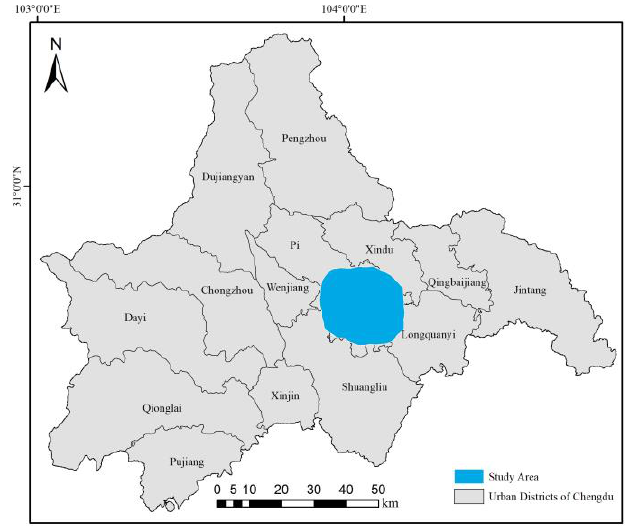
Figure 1. Study Area. The administrative division data are from the National Geomatics Center of China (http://www.ngcc.cn/ngcc/), and the research area is within the beltway of Chengdu.